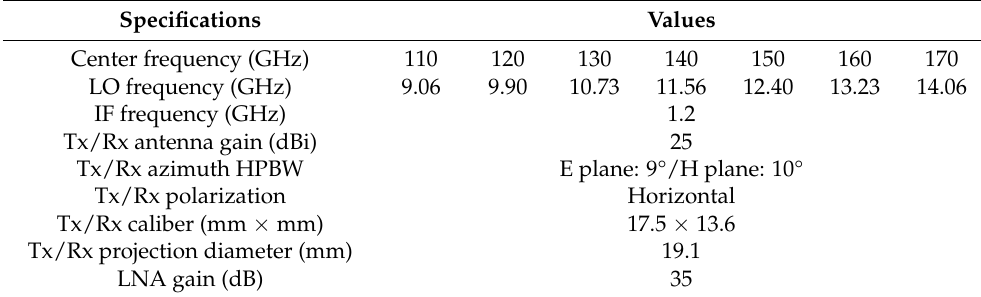
Figure 3. Transmission in free space. ( a ) LoS propagation measurement, ( b ) Reflection measurement. In the receiving end, the received signal is amplified by a low noise amplifier (LNA) with a gain of 35 dB, and then down-converted in a mixer. The local oscillator (LO) signal is generated by a continuous wave generator and up-converted by a twelve times frequency multiplier. After down-conversion, the intermediate frequency (IF) signal passes through a signal combiner and is finally measured by a signal analyzer to show its spectrum. Therefore, the characteristics of the reflected signal including frequency and power can be obtained. In order to analyze the reflection characteristics in the full D-band range, seven D-band signals with a frequency interval of 10 GHz are generated for the measurements. The detailed hardware parameters are demonstrated in Table 4. Table 4. D-band Reflection System